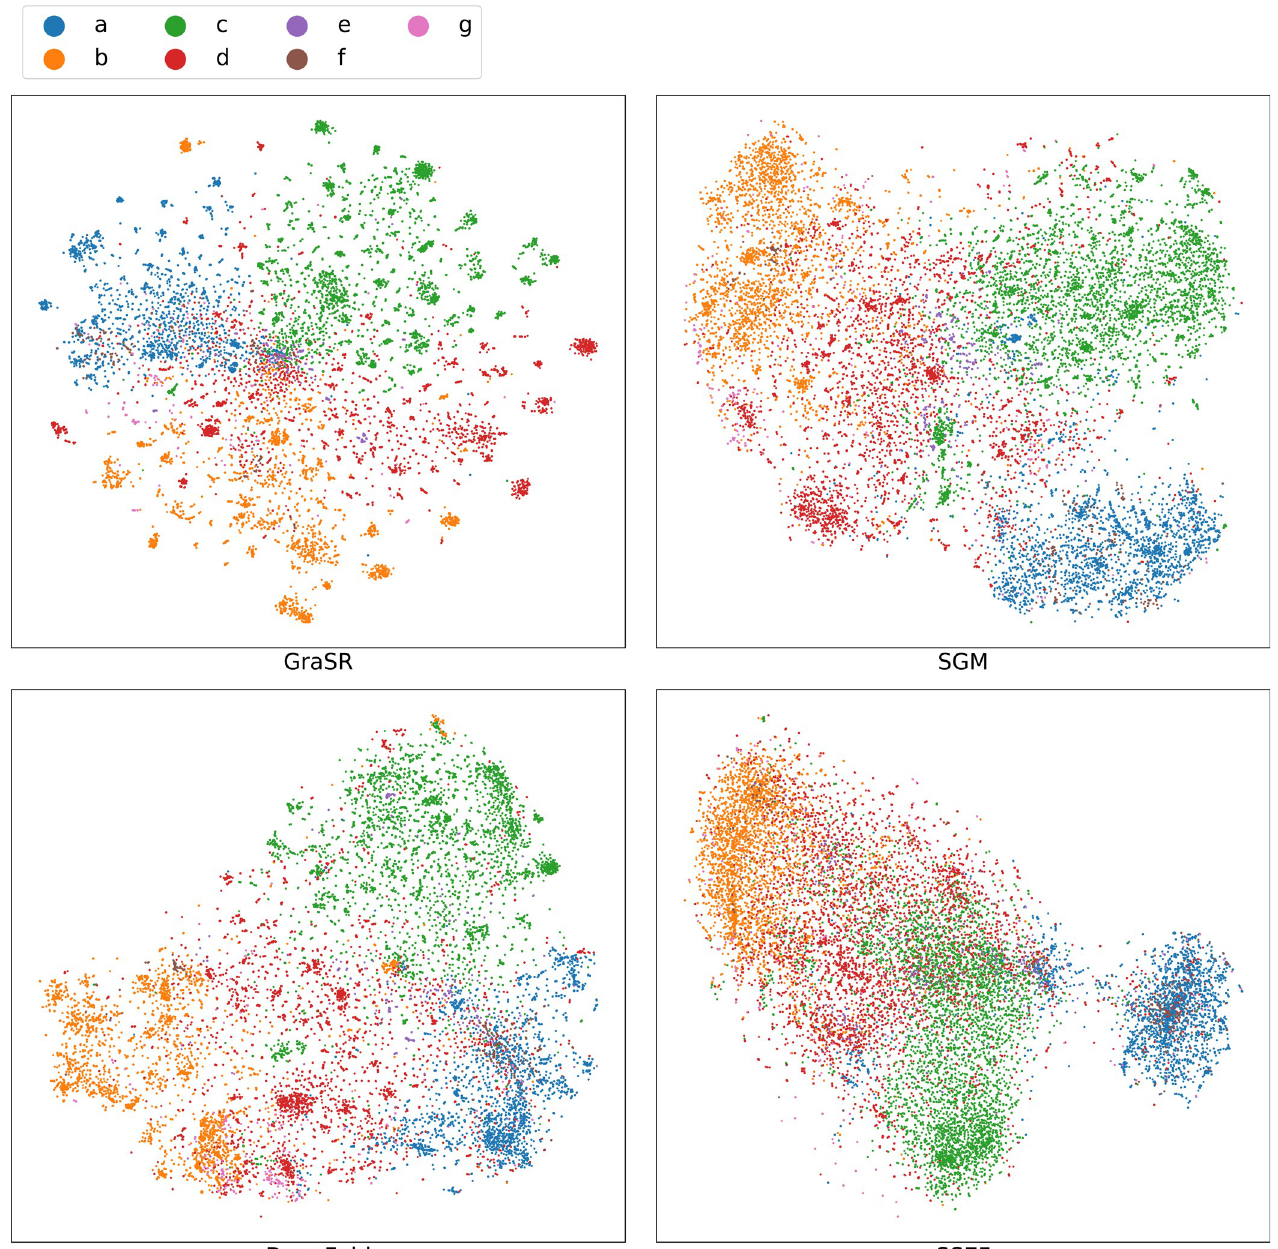
Fig 6. Visualization of descriptors learned from GraSR and other methods by t-SNE. a: All alpha proteins; b: All beta proteins; c: Alpha and beta proteins (a/ b); d: Alpha and beta proteins (a+b); e: Multi-domain proteins (alpha and beta); f: Membrane and cell surface proteins and peptides; g: Small proteins.